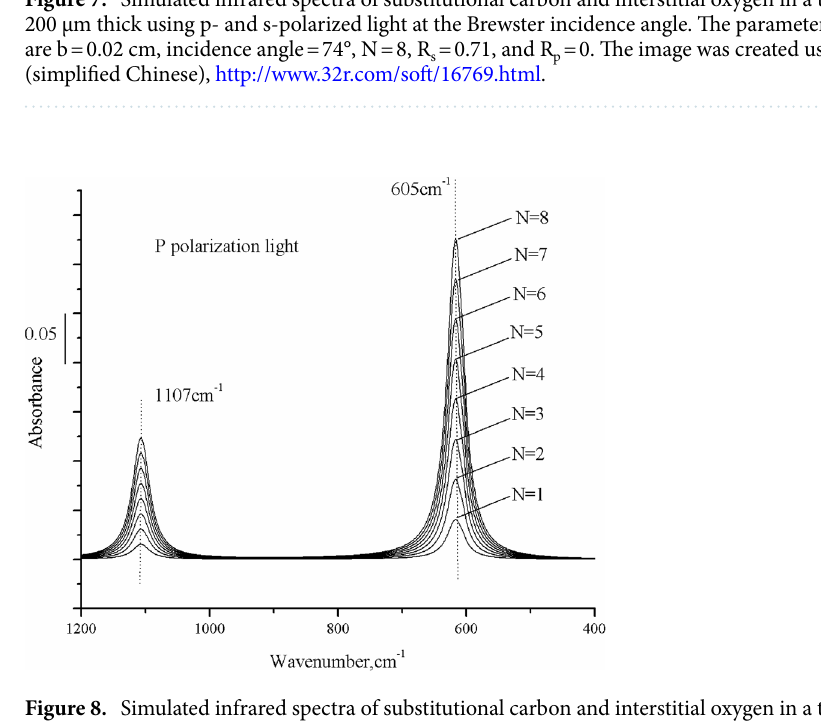
Figure 8. Simulated infrared spectra of substitutional carbon and interstitial oxygen in a thin silicon wafer using p-polarized light as a function of N. Parameters for calculation include N = 1 ~ 8, b = 0.02 cm, incidence angle = 74°, N = 8, and R p = 0. The image was created using Origin 2017 (simplified Chinese), http://www.32r. com/soft/16769